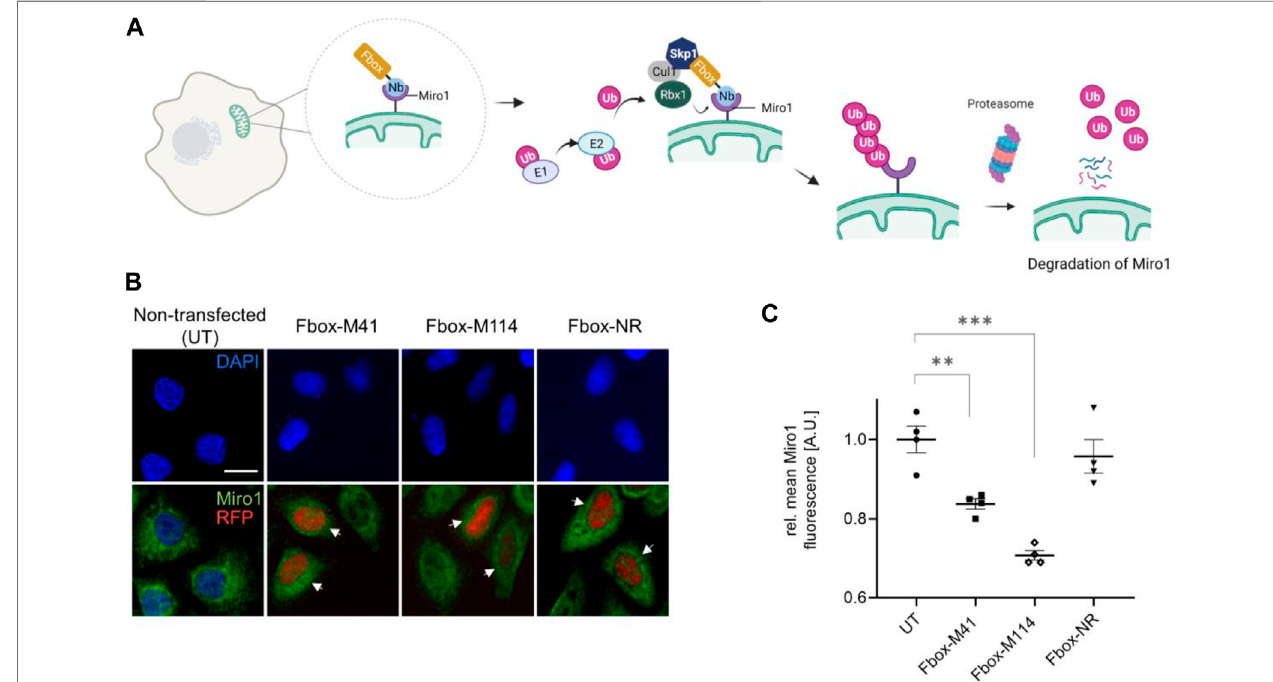
FIGURE 7 | Targeted intracellular degradation of endogenous Miro1 by Fbox-Nb-based degrons. (A) Schematic illustration of the targeted degradation of Miro1 mediated by Miro1-Nb-Fbox fusions (illustration created with Biorender.com). (B) Representative confocal images of HeLa cells transiently expressing indicated Miro1-speci fi c Fbox-Nbs (Fbox-M41 and Fbox-M114) or a non-related Fbox-Nb (Fbox-NR) construct. For quantitative IF analysis, cells were fi xed and permeabilized 24 h after transfection followed by detection of endogenous Miro1 with Miro1 antibody (shown in green). Fbox-Nb expressing cells were identi fi edbyanuclearTagRFPsignal(whitearrows)andsubjectedtoautomatedimageanalysisandquanti fi cationasdescribedin SupplementaryFigureS13 and Material and Methods. Scale bar 20 µm. (C) Mean Miro1 fl uorescence intensity from HeLa cells expressing Fbox-Nbs determined by quantitative fl uorescence imaging. Mean Miro1 fl uorescence was calculated from four samples ( N = 4; n > 500 cells) and normalized to untransfected cells, UT (set to 1). As control, a non- related Fbox-Nb construct (Fbox-NR) was used. Data are represented as mean ± SEM. For statistical analysis, student ’ s t -test was performed, ** p < 0.01, *** p <